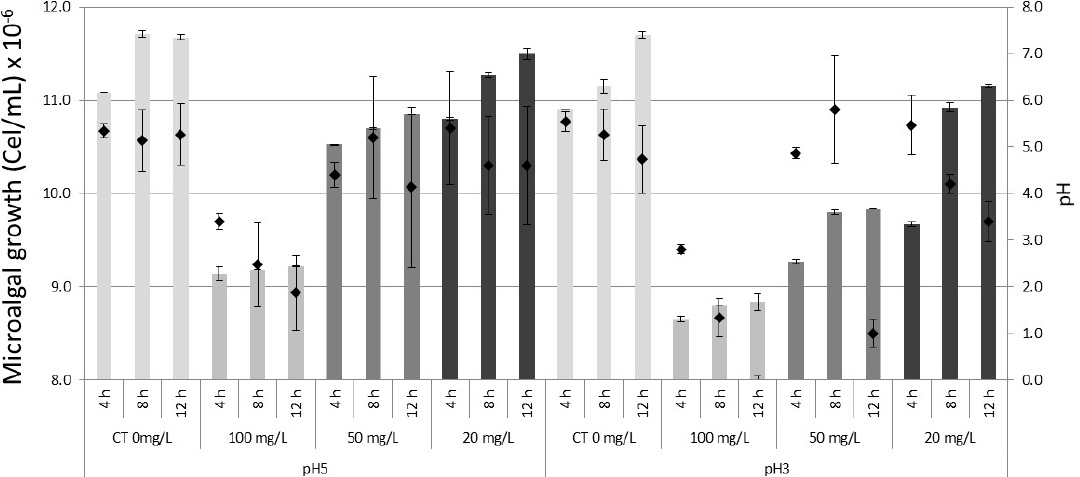
Figure 3. Growth of the microalga Muriellopsis sp. in artificial acid drainage (AAD) cultivates different pH and iron concentrations. CT (Control). The bars represent ± standard error of the mean. Diamond symbol microalgal